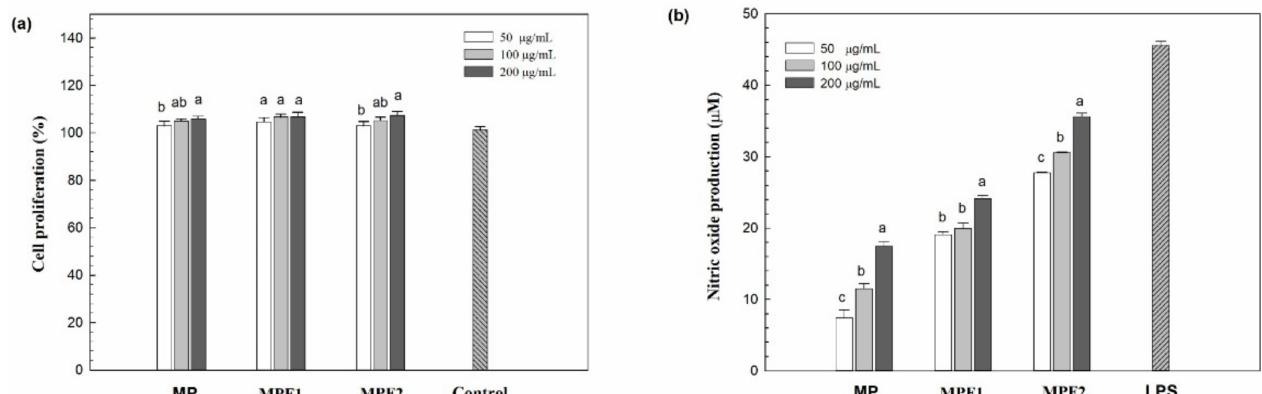
Figure 2. Effect of MP, MPF1, and MPF2 on RAW264.7 cell activity. RAW264.7 cell proliferation with different polysaccharide treatment concentrations. Medium alone was used as a control ( a ). Nitric oxide (NO) production, and the medium alone was used as a control, while LPS was used as the positive control ( b ). Values are presented as mean ± standard deviation (n = 3). Different letters a,b,c indicate significant differences ( p < 0.05) among the groups in